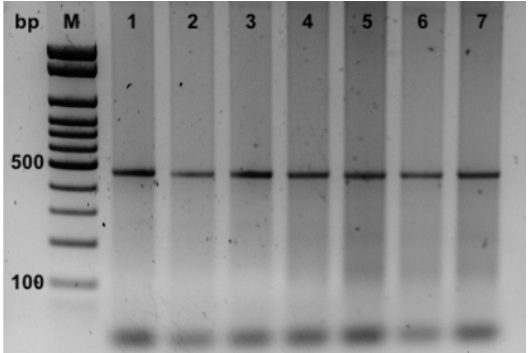
Figure 4. PCR products from DNA of samples of kidney for P. damselae subspecies identification using 76a/76b and Ure-5’/Ure-3’ primer pairs. M, 100 bp ladder; 1–7 ID of the samples.